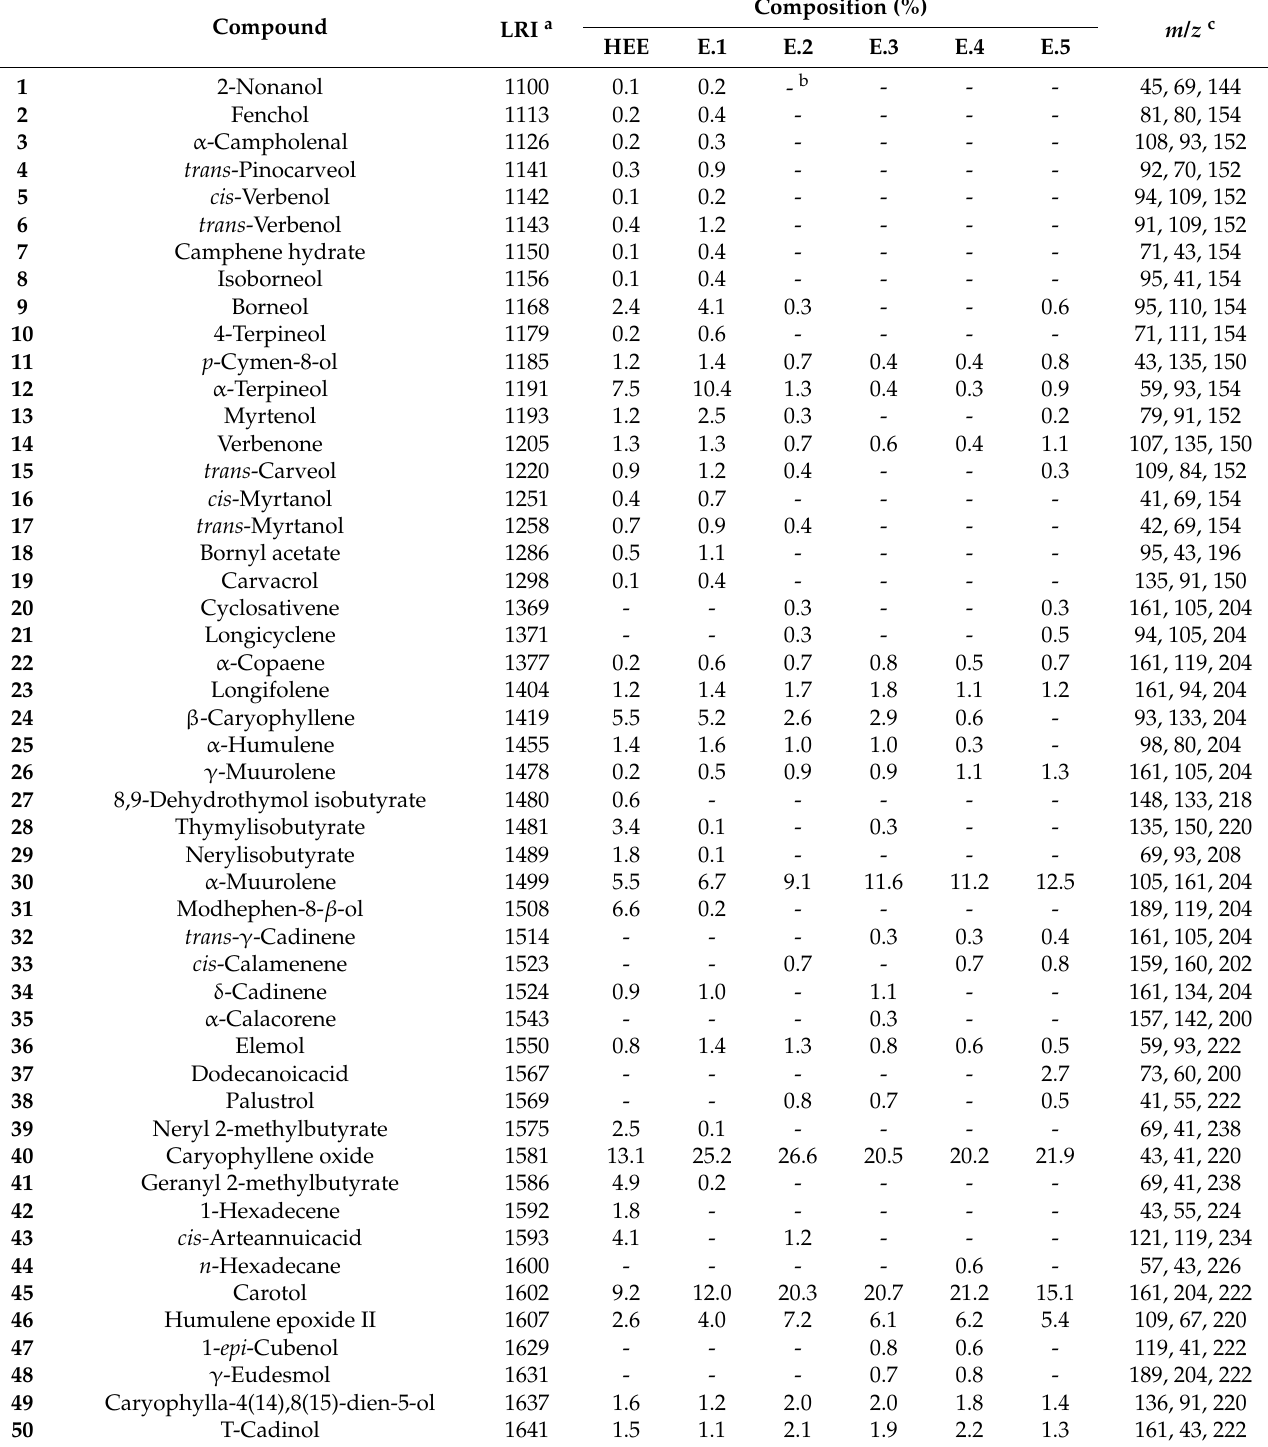
Table 1. Constituents of T. articulata trunk bark essential oil (HEE) and its fractions (E.1–E.5) identified by